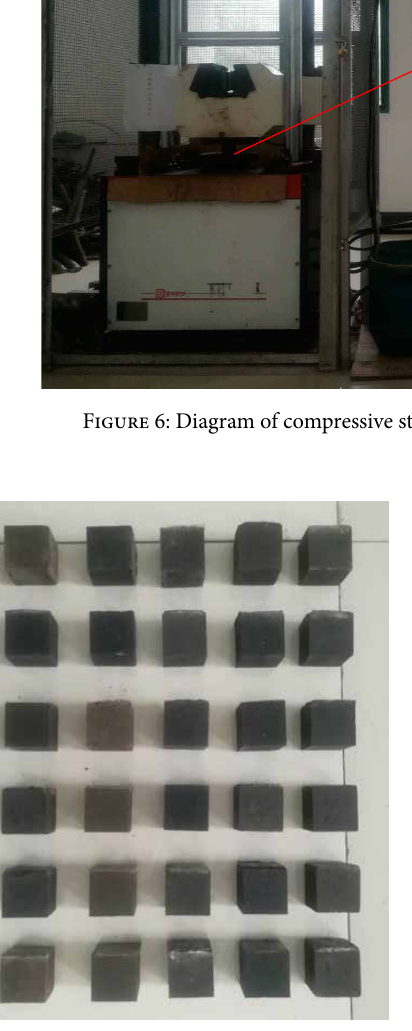
Figure 8: Gel time curve of resin anchorage at different